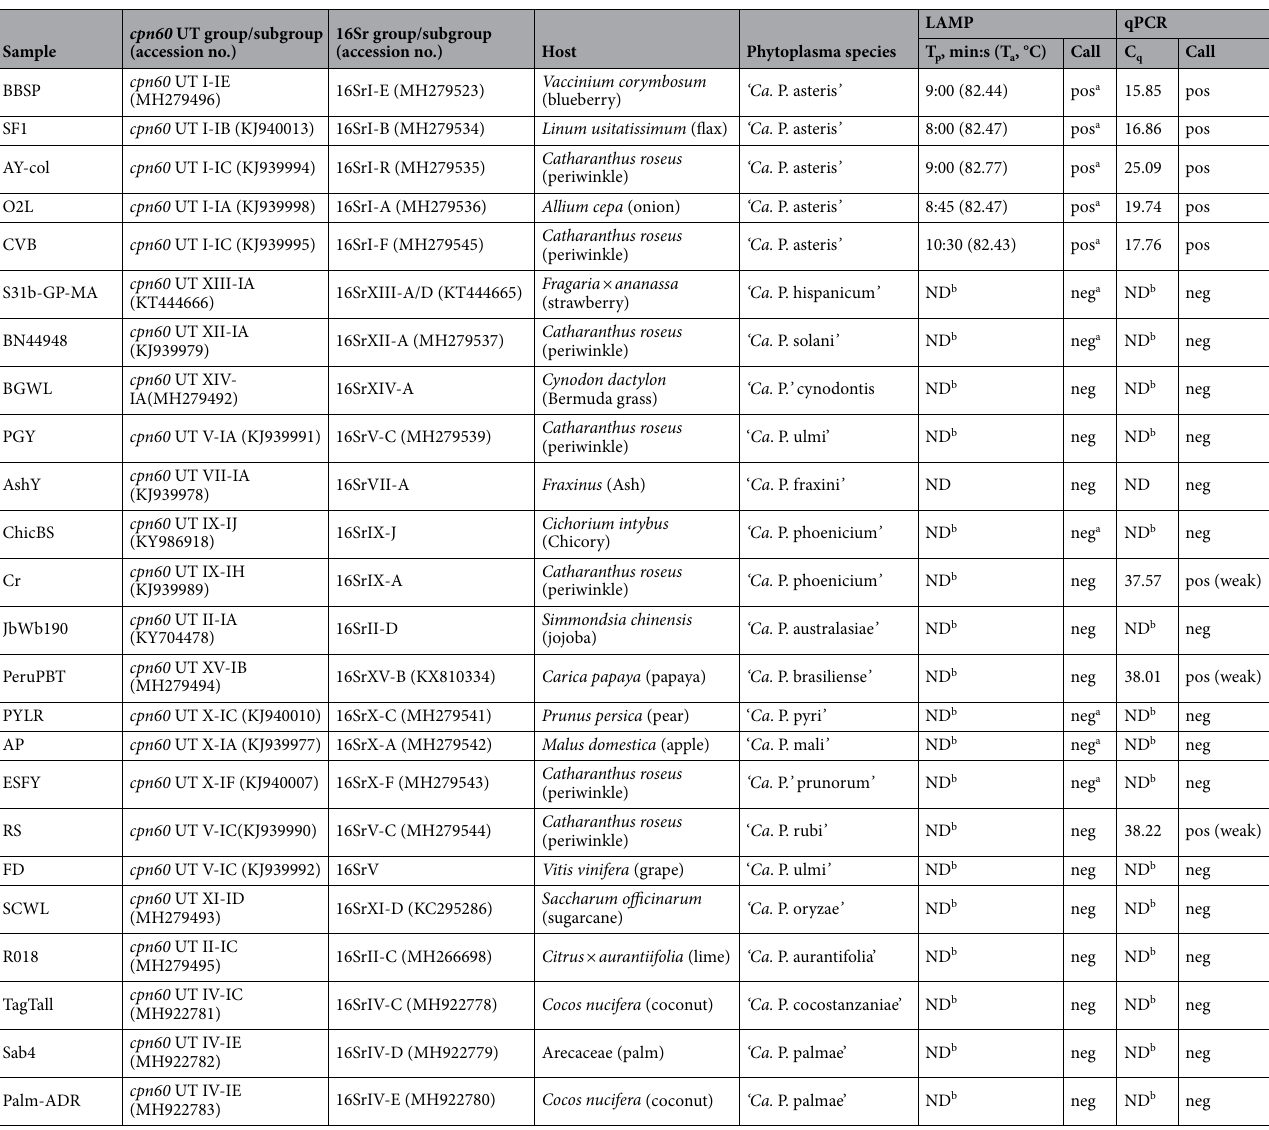
Table 1. List of samples and/or cpn60 UT clones used to measure the analytical specificity of the LAMP assay targeting BBSP. Plasmid DNA (10 7 copies, containing the cpn60 UT) amplified and cloned from plants infected with each of the specified groups and subgroups was used as template as described in the text. When available, total nucleic acids extracted from infected plant tissue was also tested, as indicated by (a). Complete descriptions of each of these strains can be found at http:// cpncl assip hyr. ca. a These samples were also tested using DNA extracted from a plant infected with the same phytoplasma, which yielded the same result. b ND not